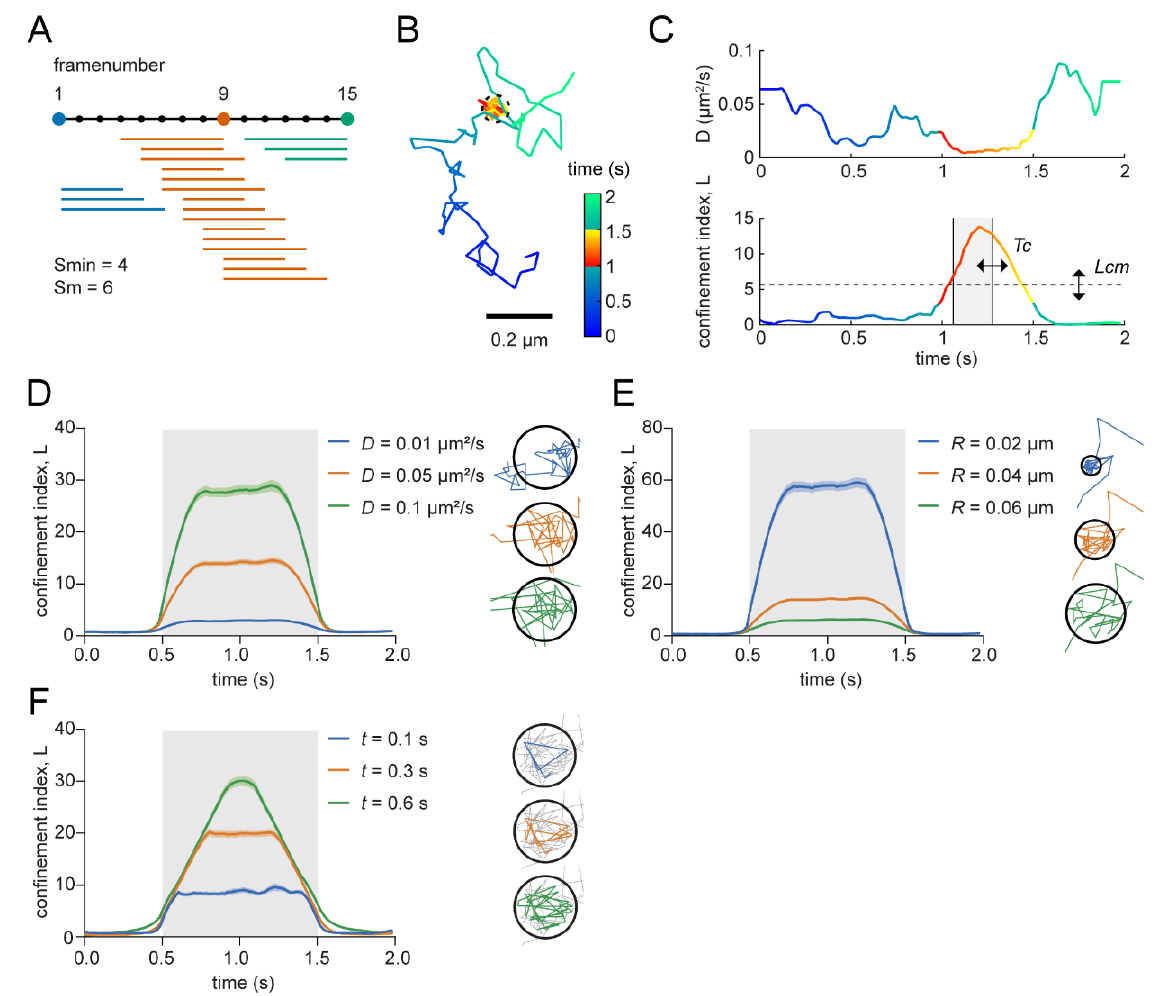
Figure 1. Influence of variables in confinement index formula. ( A ) Schematic diagram of how trajectories are divided into segments with different lengths. In this simplified example, the minimal segment length ( Smin ) is 4 frames and the maximum segment ( Sm ) is 6. All the segments are displayed that will be included in the confinement index of frame 1 (blue), 9 (orange), and 15 (green). ( B ) Simulated trajectory with a confinement zone with radius of 40 nm. Color-coded for time and confined period. Scale bar, 0.2 μm. ( C ) Diffusion coefficient (top) and confinement index (bottom) over time of the simulated trajectory in ( B ). Color-coded for time and confined period. Tc and Lcm indicate the critical time period and critical L threshold used to detect confinement periods. ( D ) Average confinement index over time for 100 simulated trajectories with three different diffusion coefficients. Simulated confined period is indicated with the gray box. Illustrations display for each condition one example segment of the track in the corresponding color. Simulated confinement radius ( Rconf ) is 0.04 μm and Sm is 15 frames. ( E ) Average confinement index over time for 100 simulated trajectories with three different simulated confinement radii. Simulated confined period is indicated with the gray box. Illustrations display for each condition one example segment of the track in the corresponding color. Diffusion coefficient is 0.05 μm 2 /s and Sm is 15 frames. ( F ) Average confinement index over time for 100 simulated trajectories with 3 different segment lengths ( Sm = Smin ). Simulated confined period is indicated with the gray box. Illustrations display for each condition one example segment of the track in the corresponding color. Diffusion coefficient is 0.05 μm 2 /s and Rconf is 0.04 μm. Data are represented as means ± SEM.